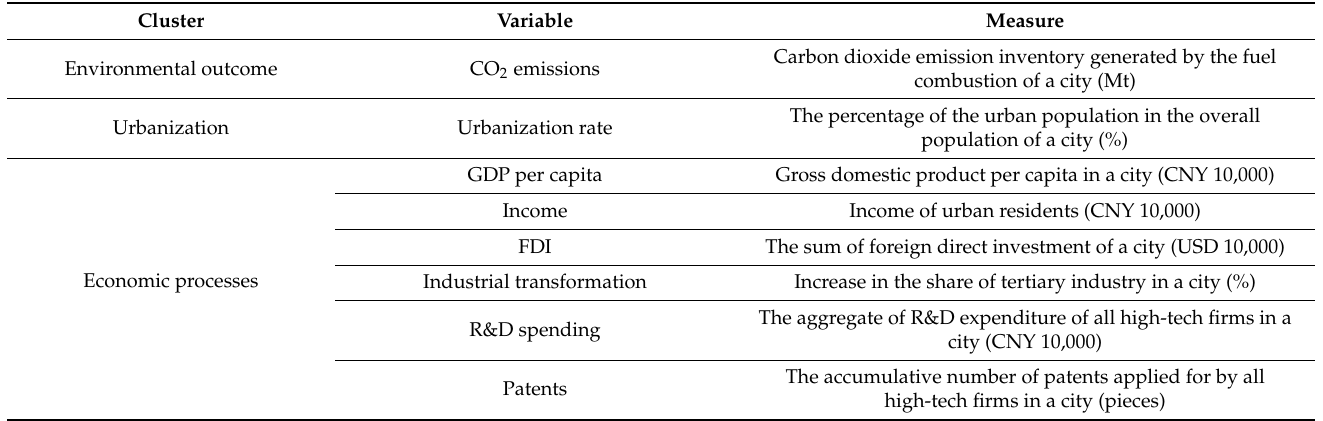
Table 1. Key variables and measures of the integrated model for the relationship between urbanization and CO 2